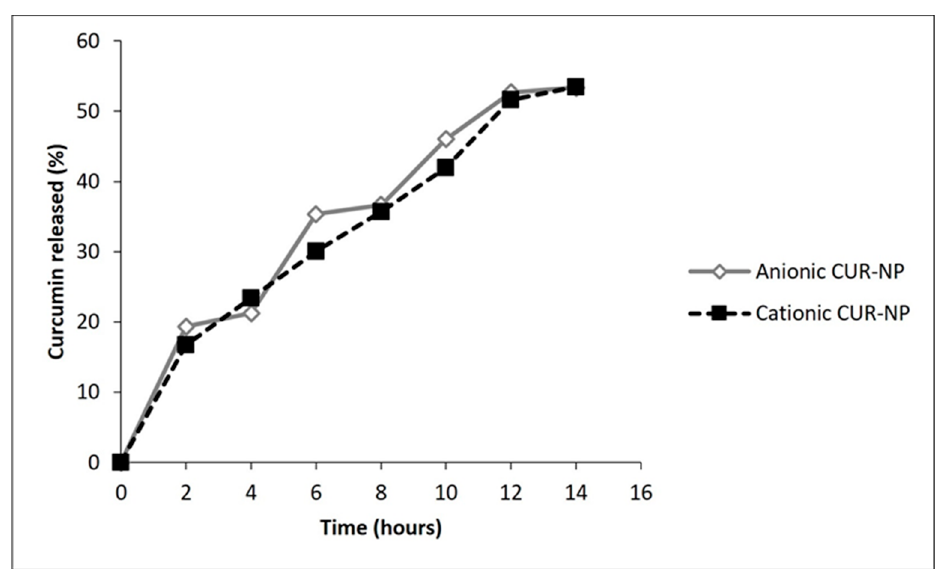
Figure 4. Release of CUR from anionic and cationic NPs (in percentage).